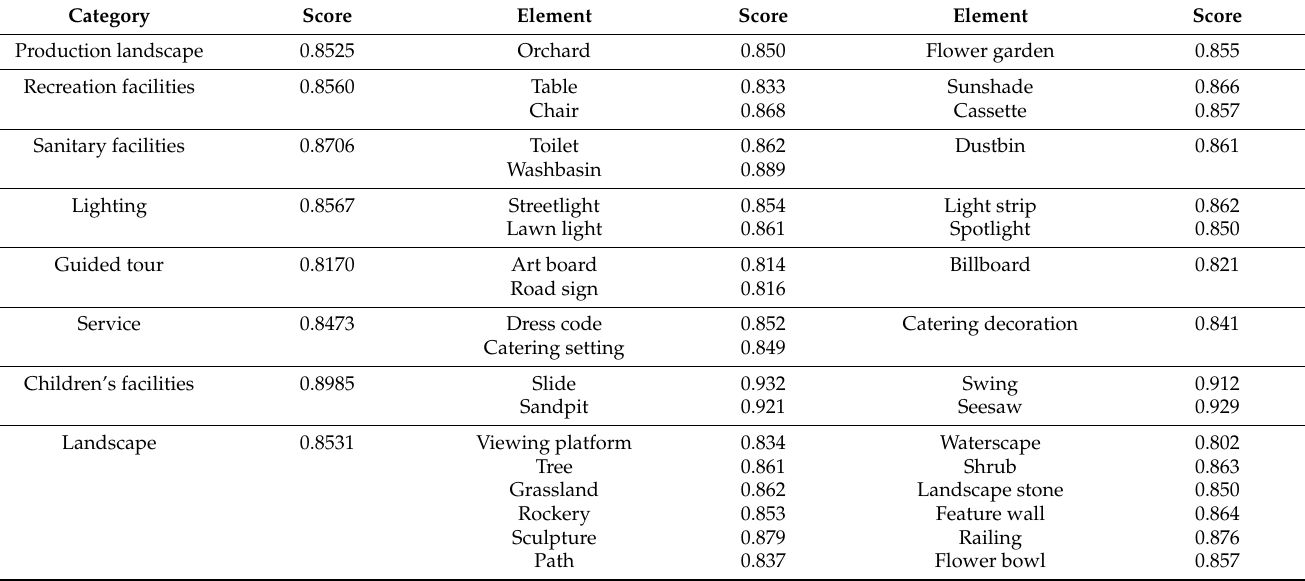
Table 3. Landscape categories and elements preference of parent–child dining